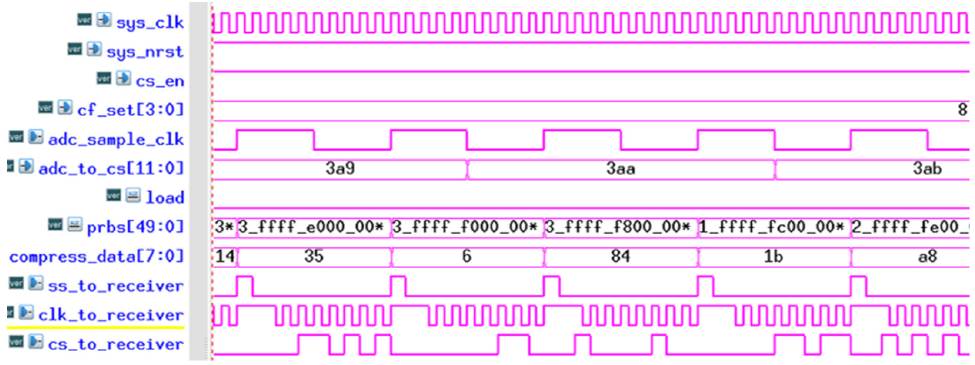
Figure 11. The functional simulation of the sampling and compression circuit.